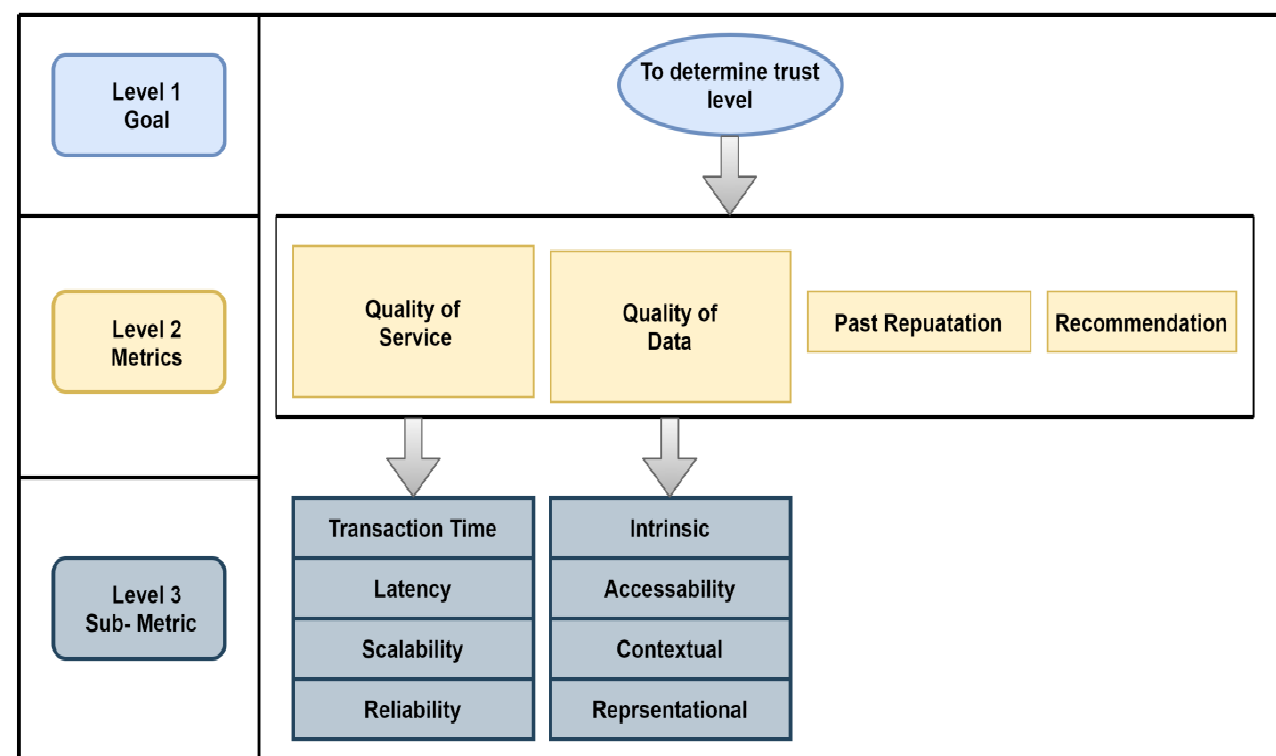
Figure 3. Trust-based computation hierarchy model (SR to SP) using fuzzy-AHP.